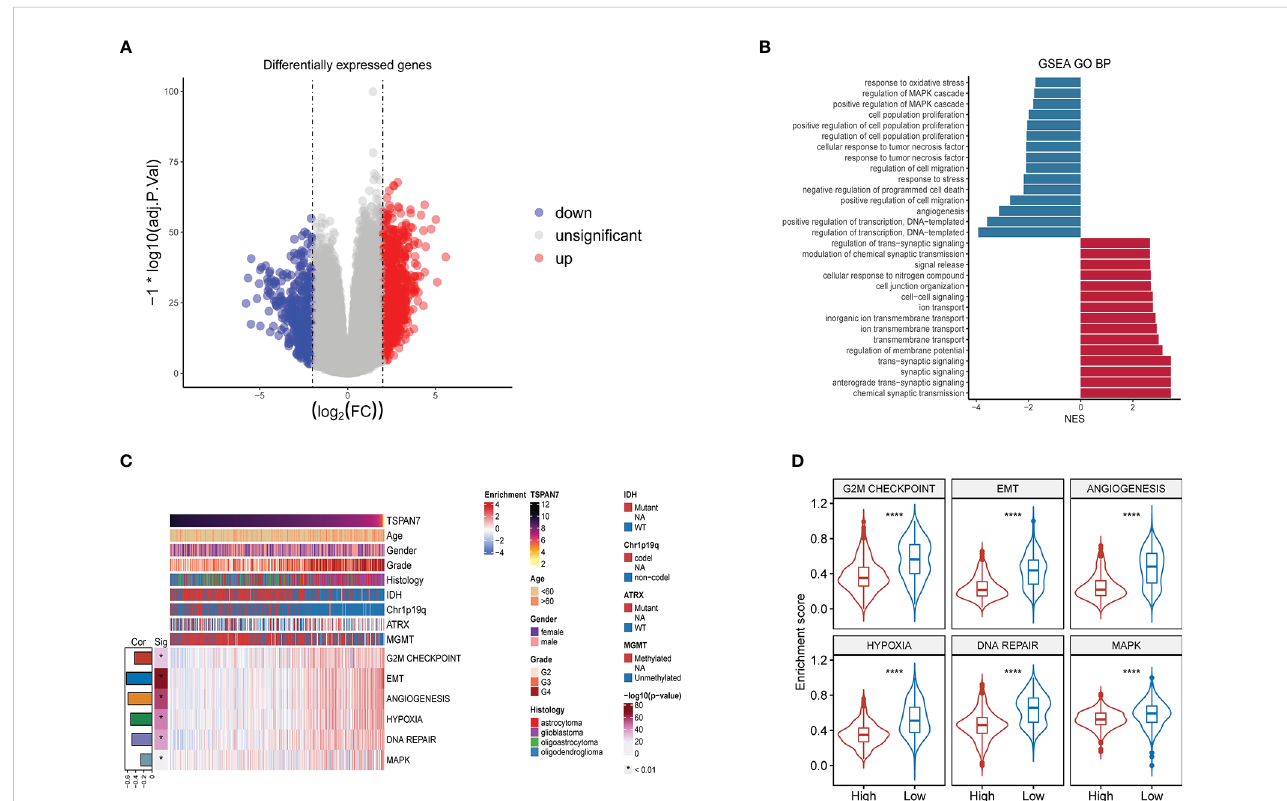
FIGURE 4 Functional enrichment analysis between the TSPAN7 high- and low ‐ expression groups in gliomas. (A) Differential expression genes (DEGs). (B) GO analysis of the up-regulated gene in the high TSPAN7 subgroup and the down-regulated gene in the high TSPAN7 subgroup. (C) The relationship between TSPAN7 and proliferation, migration, DNA repair and MAPK signal pathway in the TCGA datasets. (D) Differences in enrichment scores between TSPAN7 high and low expression subgroups in cell proliferation, EMT, angiogenesis, hypoxia, DNA repair and MAPK signaling pathways. ****p